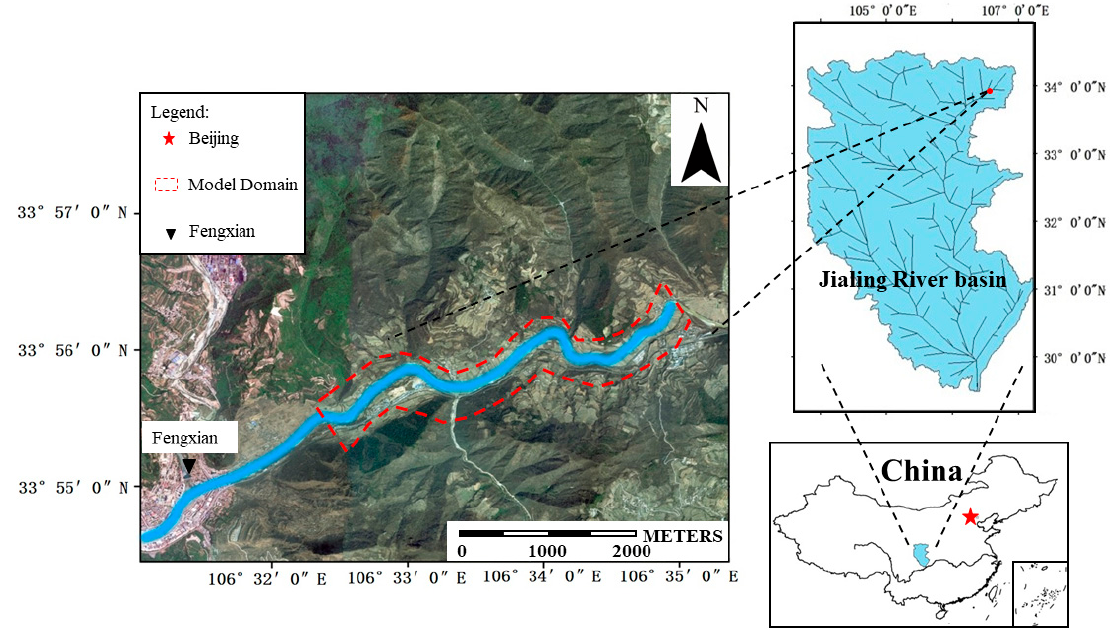
Figure 1. Location of project section of the Jialing River, China.